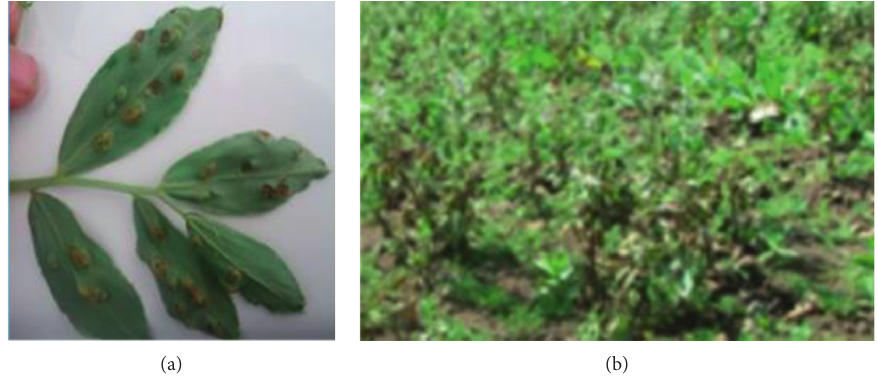
Figure 1: (a) Faba bean leaf with gall [19]. (b) Highly infested faba bean field